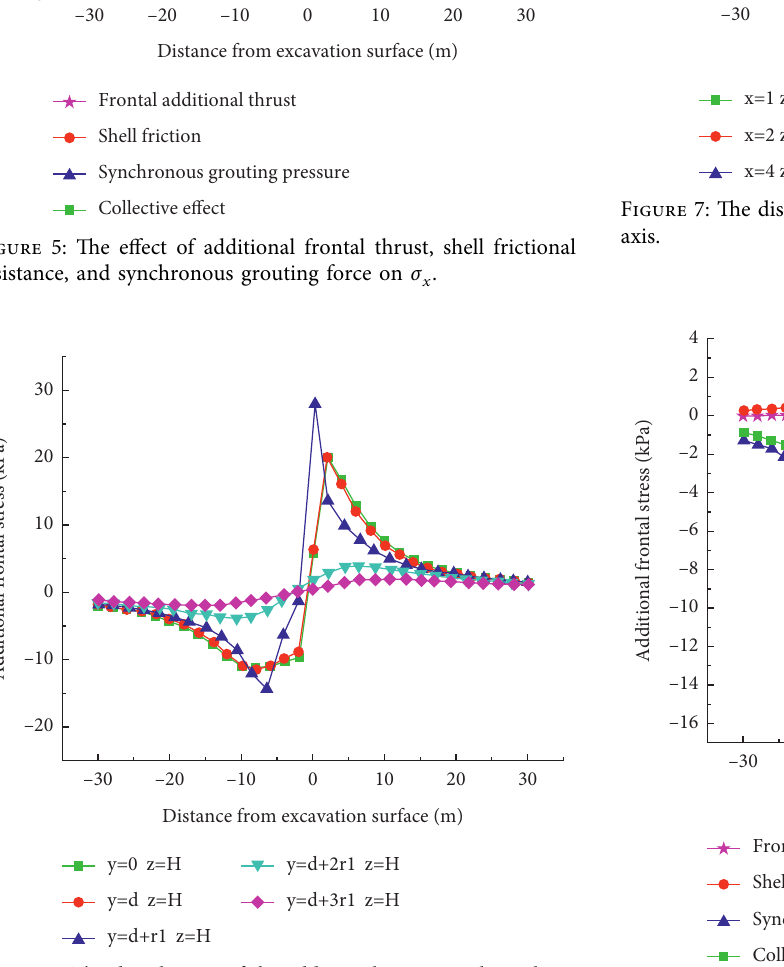
x along the X Figure 8: The effect of additional frontal thrust, shell frictional resistance, and synchronous grouting force on σ y